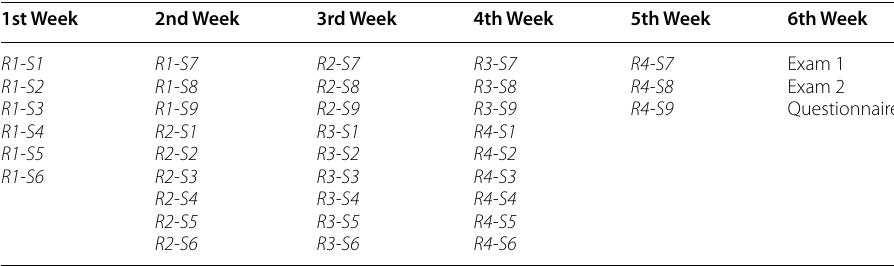
Table 3 Scheme of the